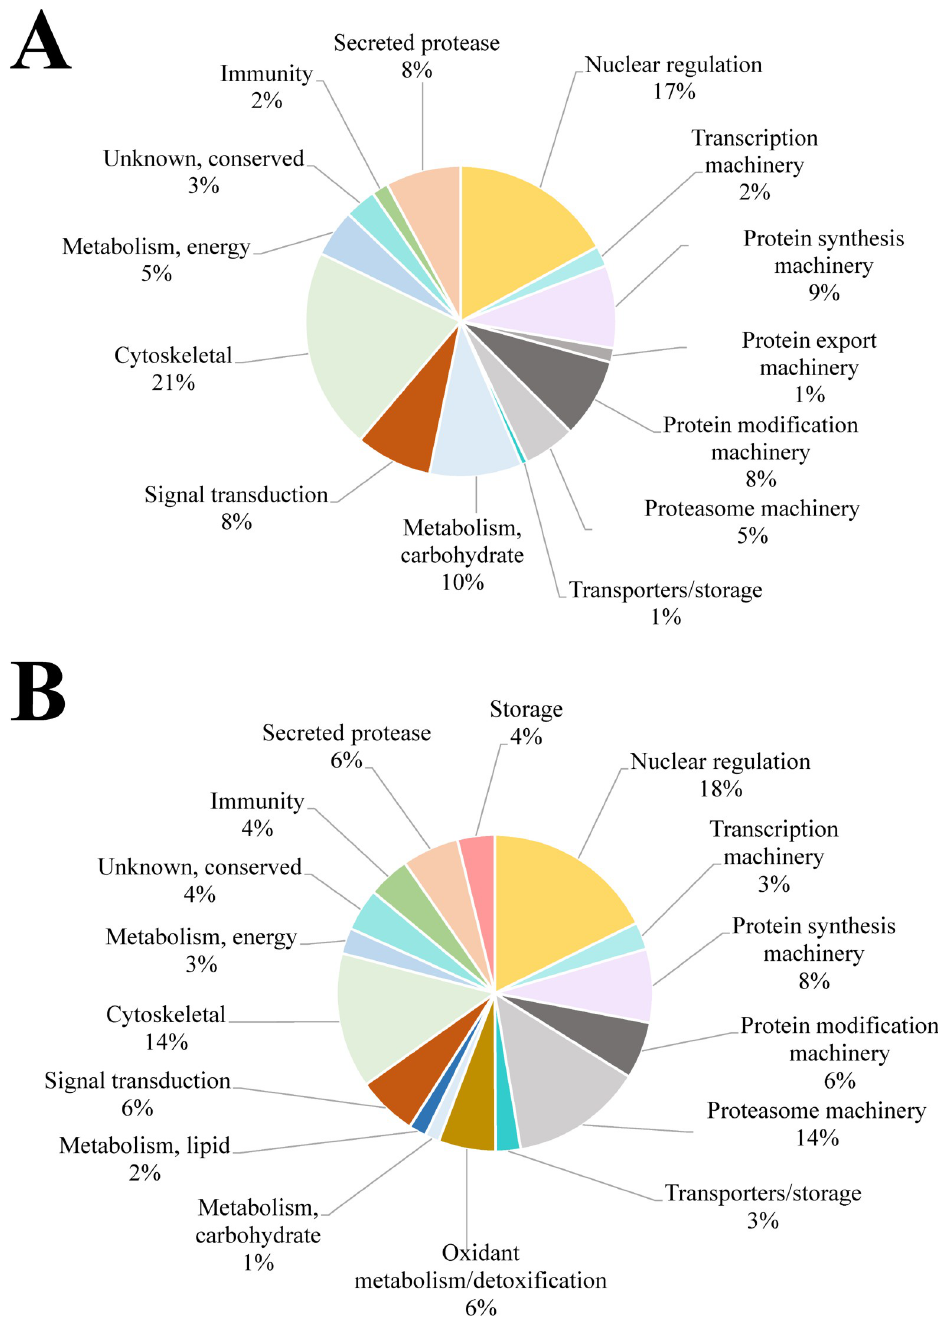
Fig 3. Functional annotation of M . unguiculatus -derived proteins found in P . kellicotti samples. Pie chart representing the percentage of proteins found in each sample with respect to NSAF values. A . soluble somatic proteins (SSP) sample type B . excretory/secretory proteins (ESP) sample